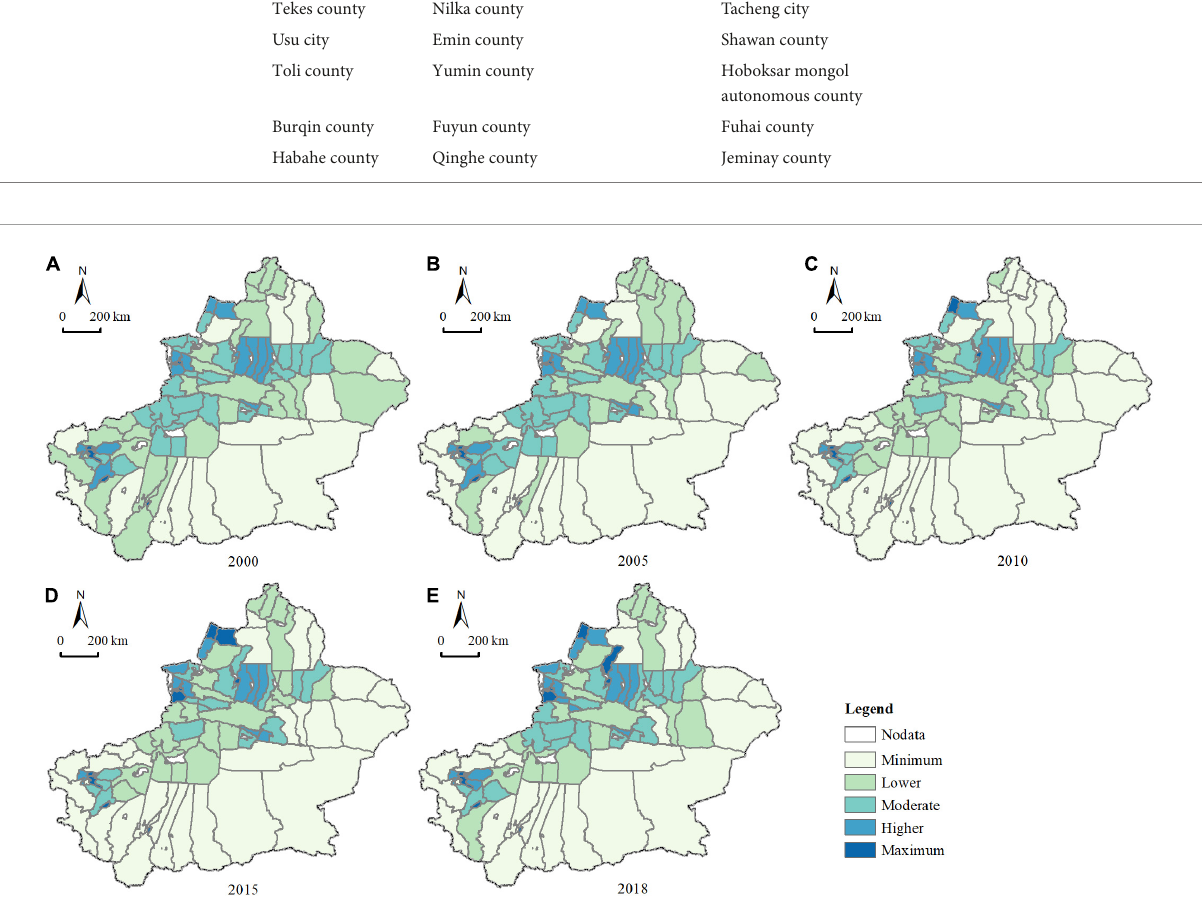
FIGURE3 Spatial distribution of farmland use pattern index in (A) 2000, (B) 2005, (C) 2010, (D) 2015, and (E) 2018.